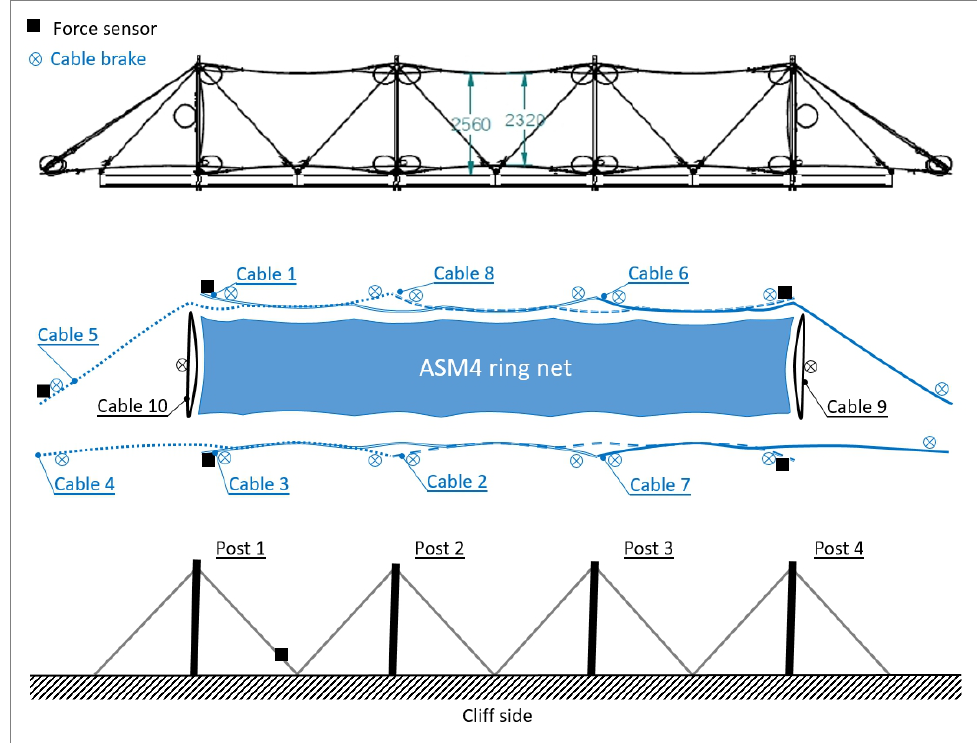
Figure 2. Architecture of the experimental flexible-barrier. Top : Technical drawing from above of the barrier by courtesy of the NGE Foundation. Middle : Decomposition of the supporting cable and of their weaving with the ASM4 ring net. The circle at the cables end represent the brakes (“snake” brake provided by the NGE Foundation), and the black square represents the force sensors. Bottom : Supporting structures made of post and